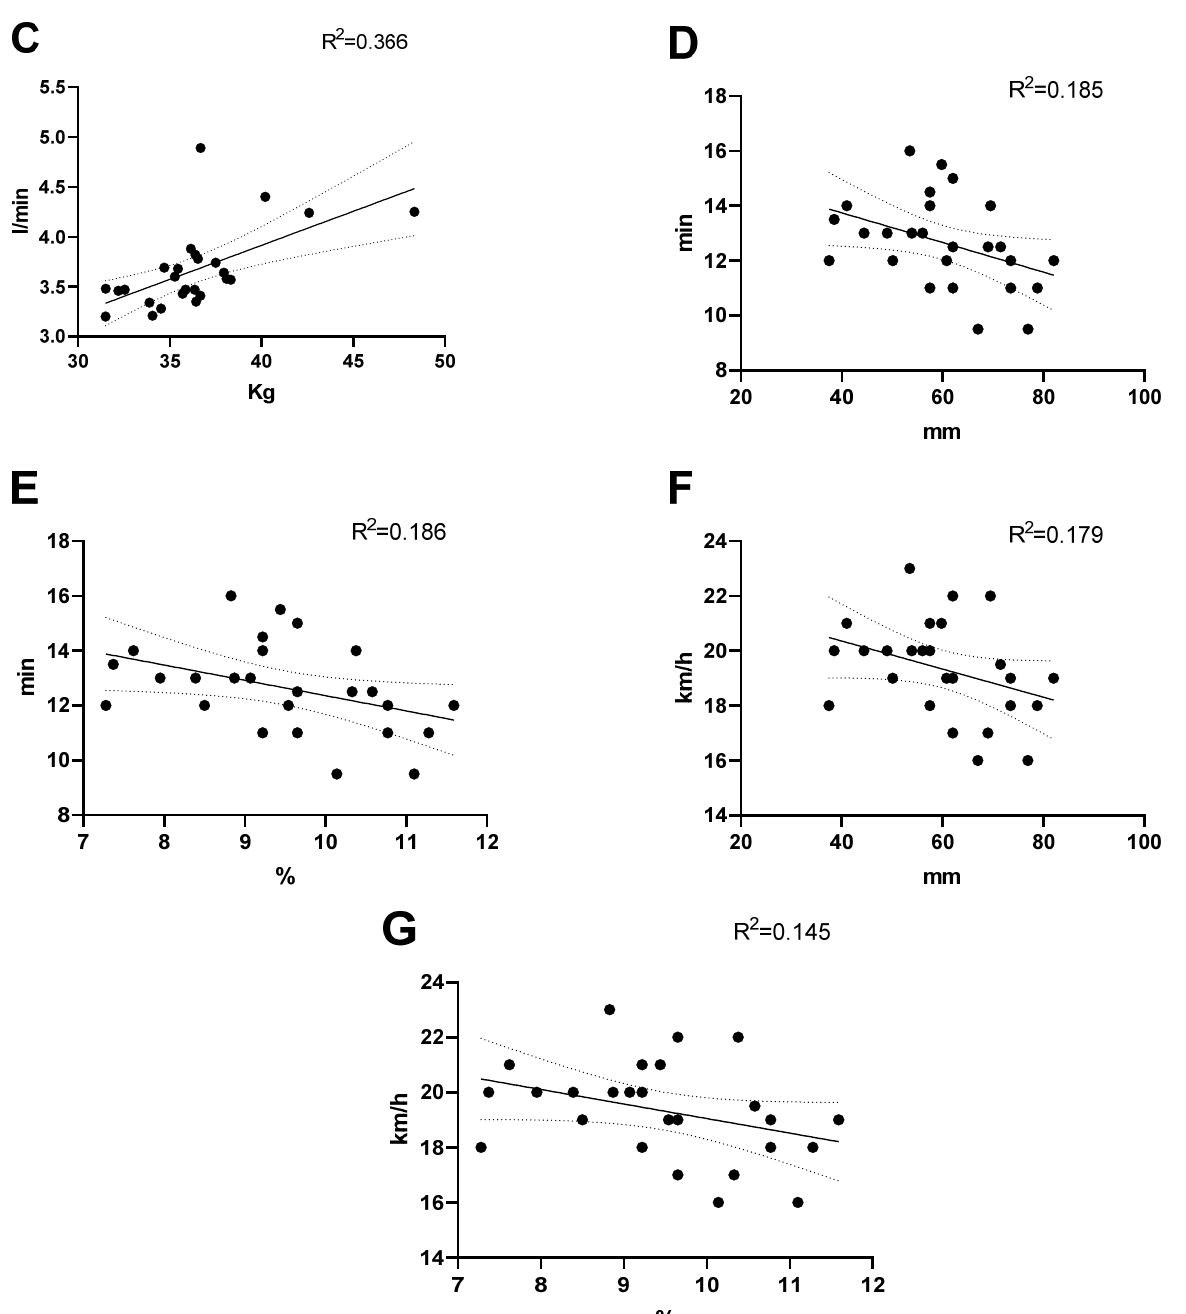
Figure 1. Linear regressions of statistically significant correlations in men soccer players. ( A ) VO 2max and stretch stature; ( B ) VO 2max and body mass; ( C ) VO 2max and muscle weight; ( D ) maximum time in the incremental test and skinfolds; ( E ) maximum time in the incremental test and fat percentage; ( F ) maximum speed in the maximum incremental test and skinfolds; ( G ) maximum speed in the maximum incremental test and fat percentage; VO 2max : maximum oxygen uptake.